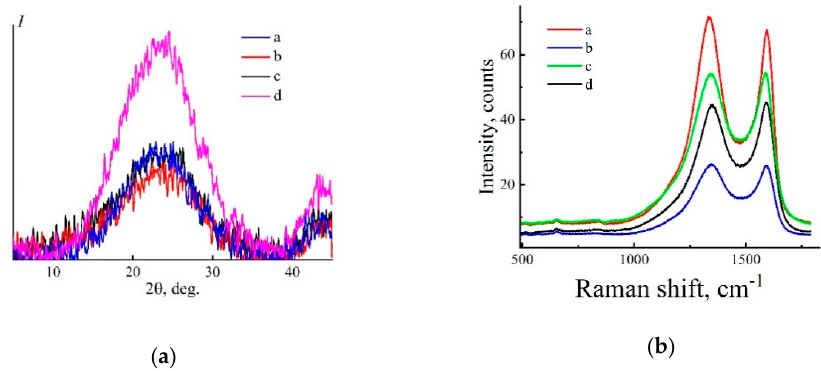
Figure 10. Equatorial diffraction patterns ( a ) and Raman spectra ( b ) of carbon fibers (CF) obtained through water (a), isobutanol baths (25 (b) and 70 ◦ C (c)), washed in water and dried, as well as from through water (a), isobutanol baths (25 (b) and 70 °C (c)), washed in water and dried, as well as from an industrial sample of Lyocell fibers (d) after heating up to 1200 ◦ an industrial sample of Lyocell fibers (d) after heating up to 1200 °C.